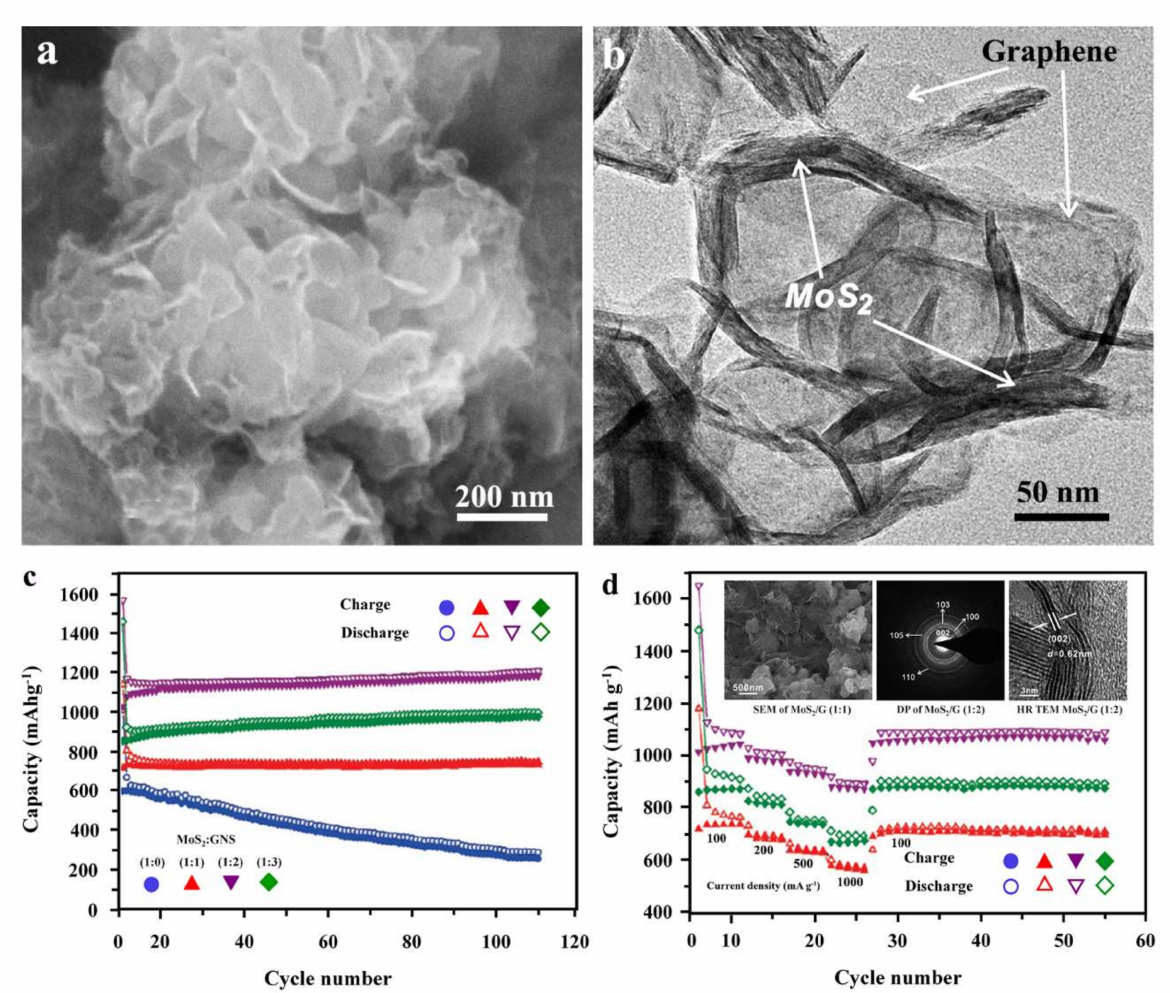
Figure 16. Morphology and electrochemical properties of layered MoS 2 /graphene composites (MoS 2 /G) synthesized in variable ratios; Morphology of layered MoS 2 /graphene composites (MoS 2 /G) synthesized in 1:2 ratio ( a ) SEM image, ( b ) TEM image; electrochemical properties of layered MoS 2 /graphene composites (MoS 2 /G) synthesized in variable ratios, ( c ) cycling behavior of MoS 2 , MoS 2 /G (1:1), MoS 2 /G (1:2), and MoS 2 /G (1:3) after annealing in H 2 /N 2 at 800 ◦ C for 2 h at a current density of 100 mA g − 1 ; ( d ) Rate capability of MoS 2 /G samples at different current densities (inset provided the SEM image, SAED pattern and HRTEM images of MoS 2 /G composites). Adapted and reproduced with permission from Ref. [52]. Copyright 2011 American Chemical